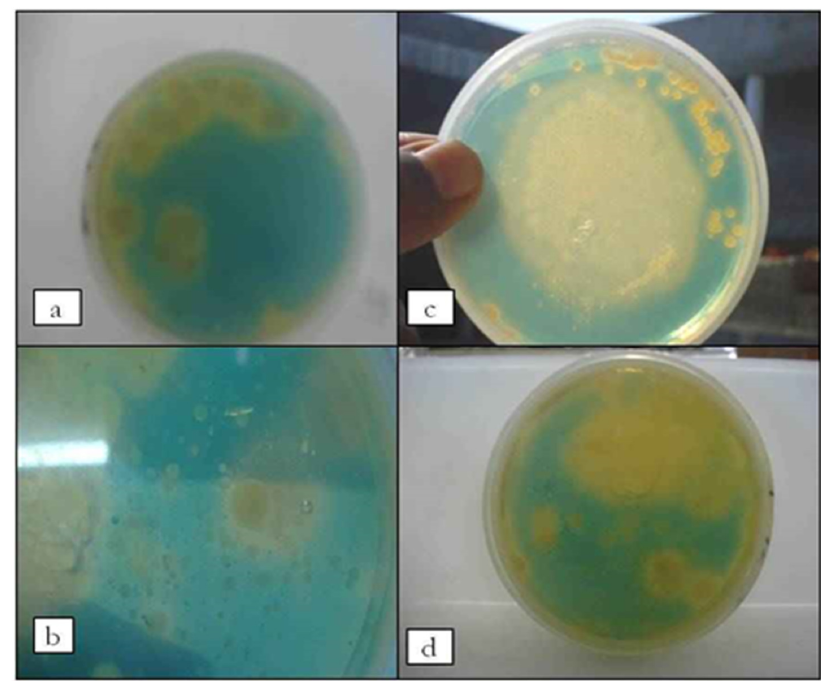
Figure 1. CAS overlay method. Figure a-d shows zone in CAS overlayer by different soil sample